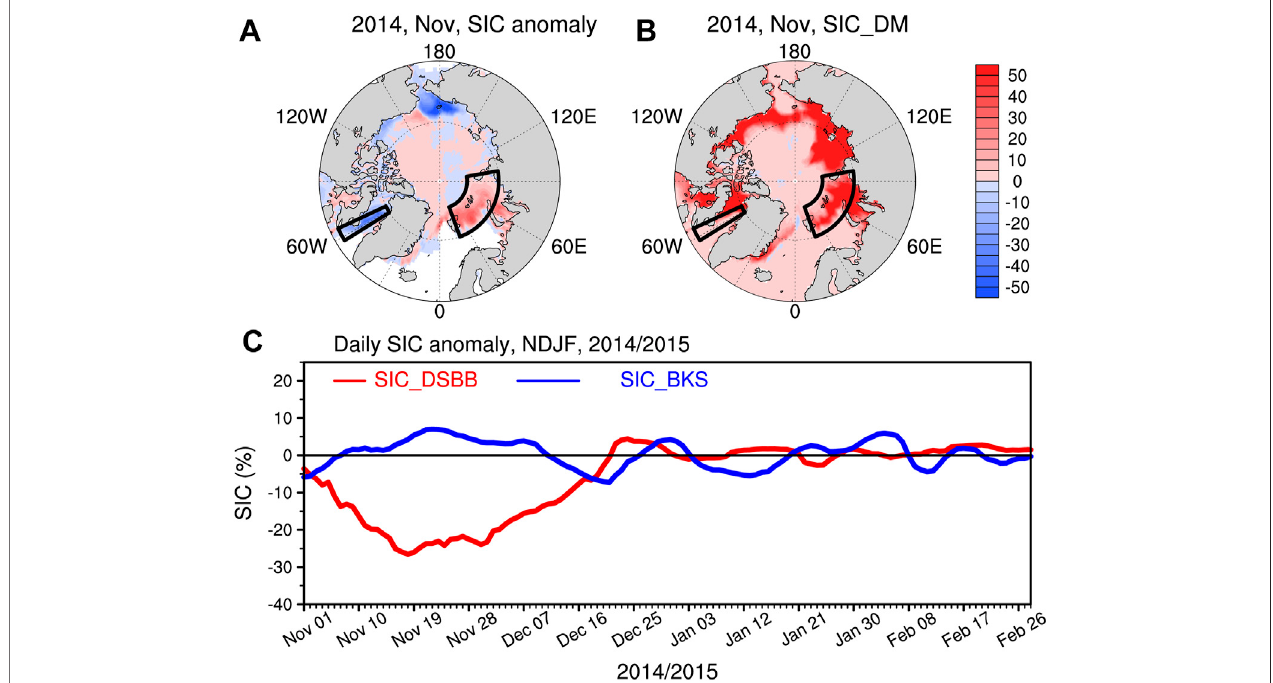
FIGURE 7 | The (A) anomalies and (B) month-to-month increments of Arctic SIC (unit: %) in November 2014. (C) Time series of daily SIC-DSBB and SIC-BKS anomalies.